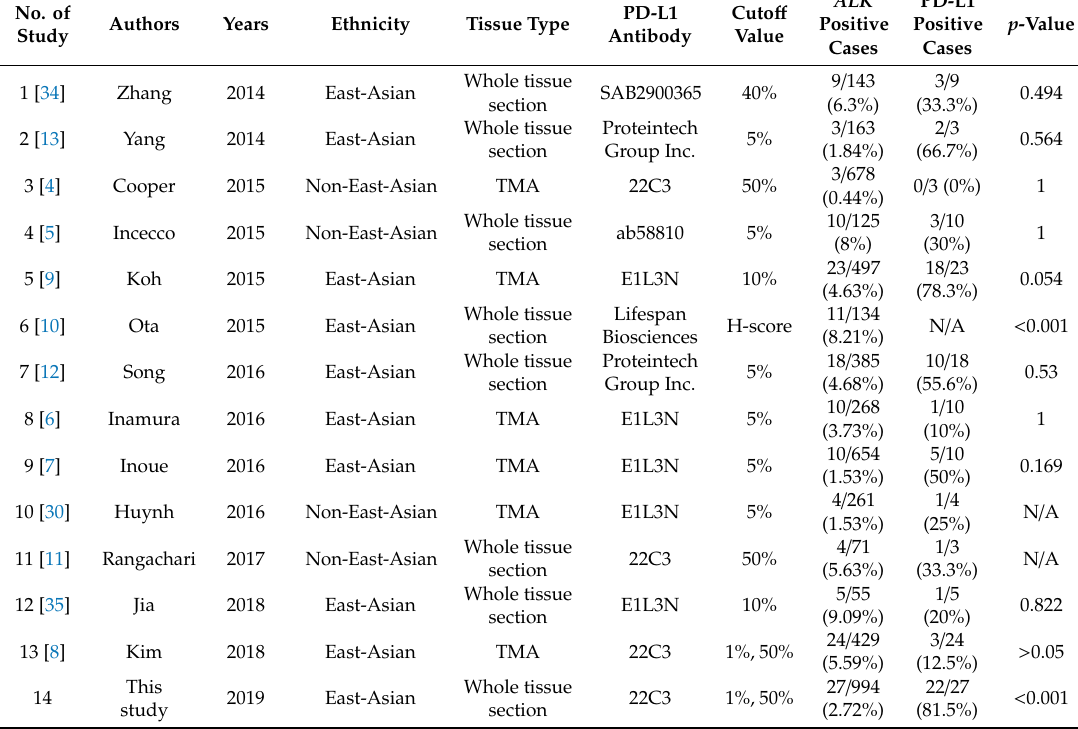
Table 7. Summary of cases showing the association between PD-L1 expression and ALK positive in published